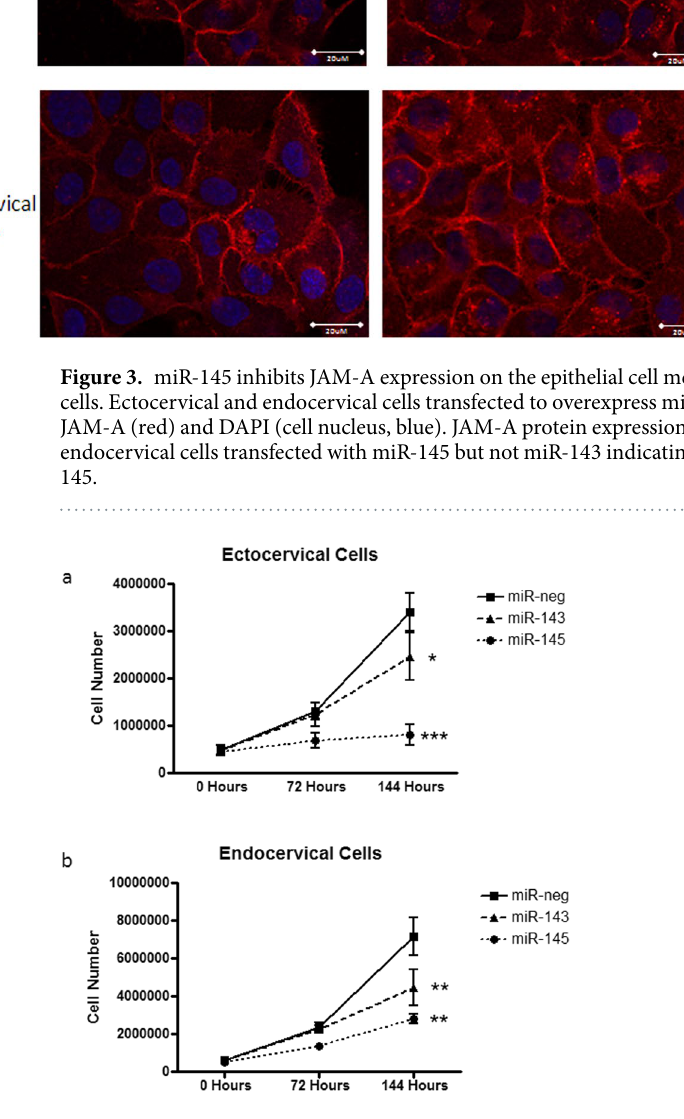
Figure 4. Ectocervical and endocervical cell number is decreased by miR-143 and miR-145. Ectocervical and endocervical cells transfected to overexpress miR-143 and miR-145 were counted at 0, 72 and 144 hours after transfection. The total number of ectocervical ( a ) and endocervical ( b ) cells were significantly decreased in both miR-143 and miR-145 transfected cells when compared to the miR-negative transfected cells after 144 hours of growth. Values are mean ± SEM. * p < 0.05, ** p < 0.001, *** p <